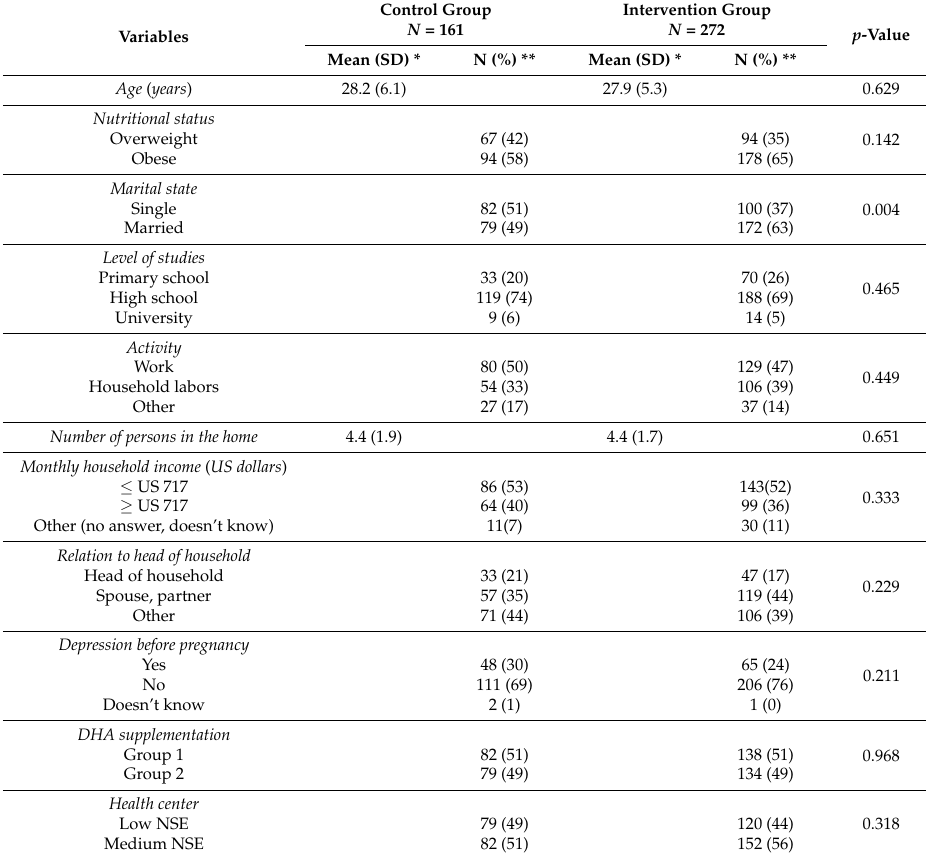
Table 1. Characterization of the study